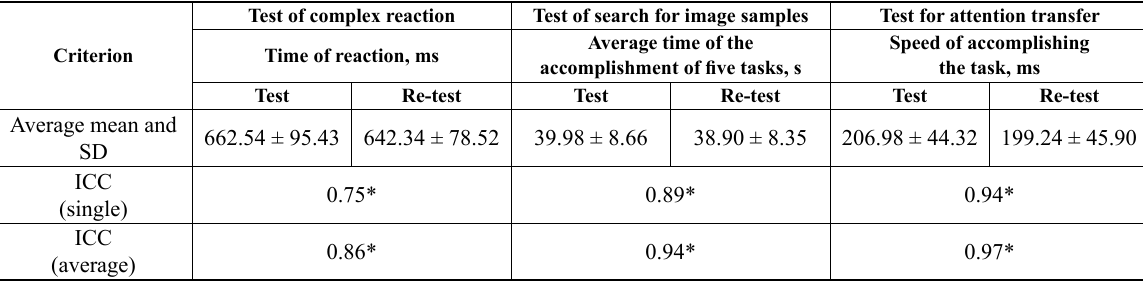
Table 2. Results of the assessment of the reliability of attention tests